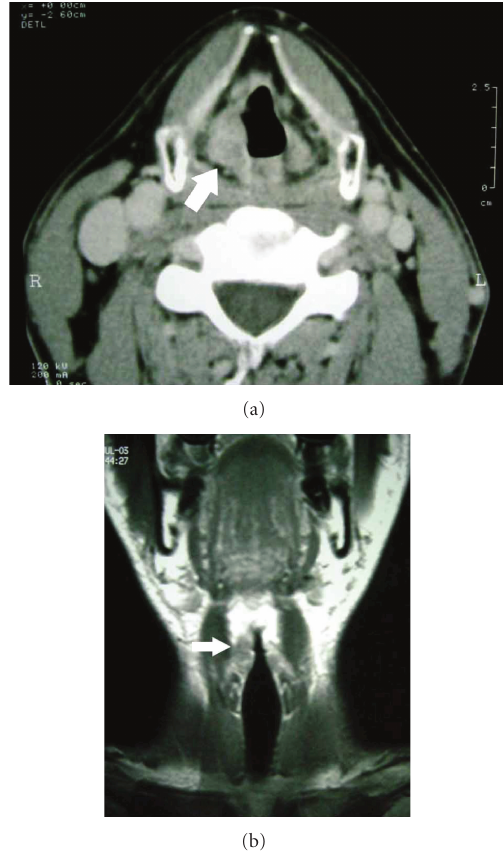
Figure 2: CT-scan (a) and MRI (b) showing a swelling of the right false cord (arrows) with involvement of the paraglottic space and without a sign of significant lymphadenopathy.